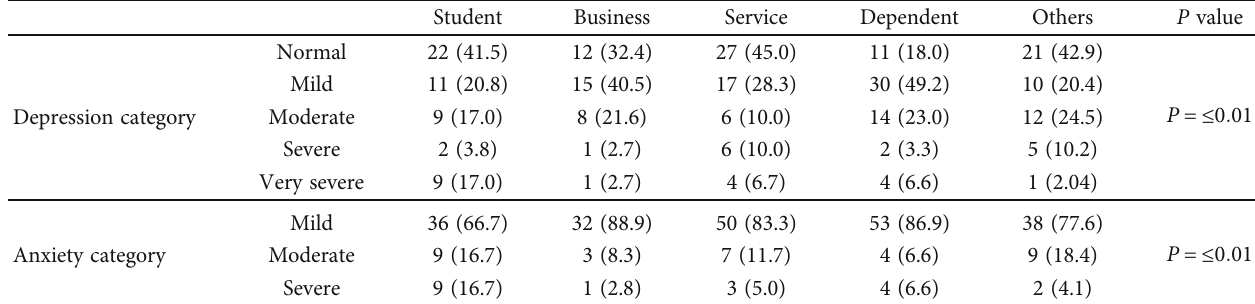
Table 5: Association of occupation with anxiety and depression ( n = 260